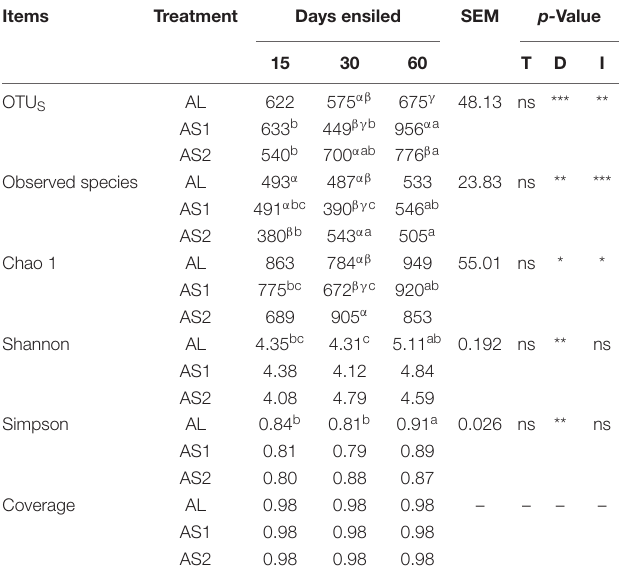
TABLE 5 | Alpha diversity of the alfalfa silage bacterial communities. Items